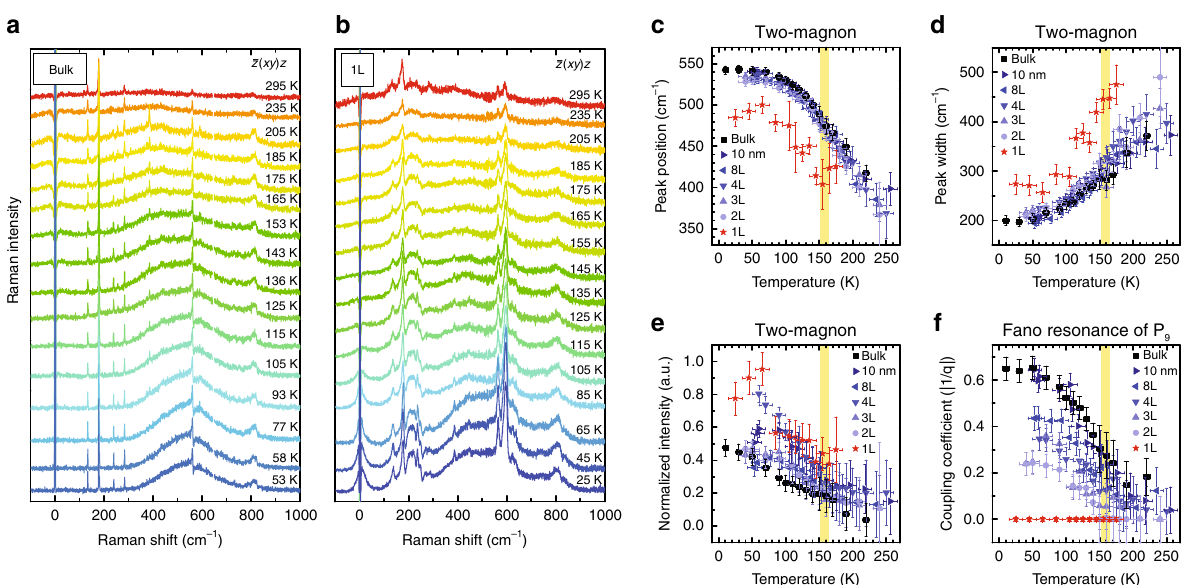
Fig. 3 Temperature dependence of two-magnon signals and Fano resonance of P 9 . a , b Raman spectra of bulk ( a ) and monolayer ( b ) NiPS 3 in cross- polarization as a function of temperature. c – f Peak position ( c ), width ( d ), and normalized intensity ( e ) of two-magnon signals; and coupling coef fi cient (|1/ q |) of Fano resonance of P 9 ( f ) as a function of temperature for various thicknesses. Error bars indicate the experimental uncertainties in temperature and the uncertainties in the fi tting procedure to determine each parameter